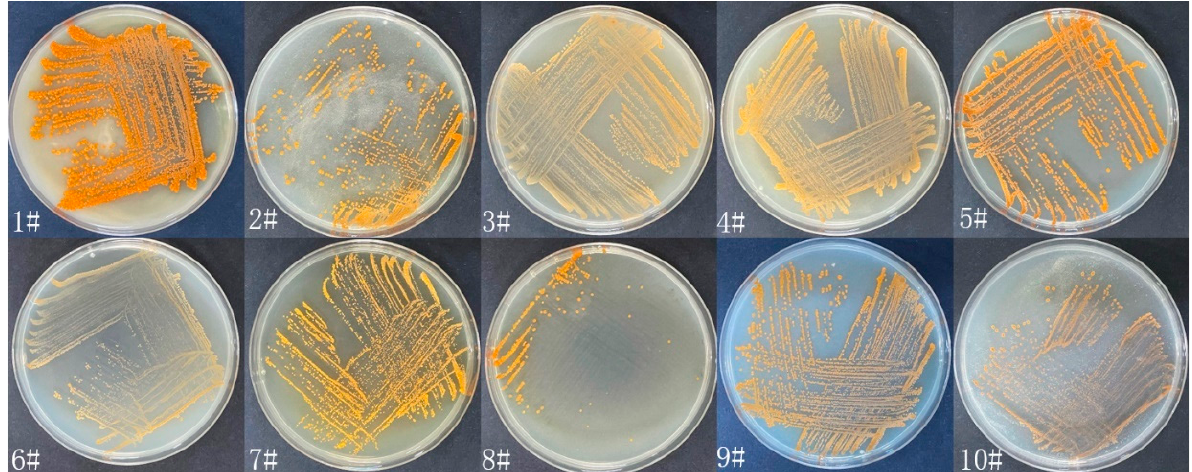
Figure 3. Nematicidal activities of ethyl acetate extracts of strain WH06 cultured in NB and LB media. CP represents blank control with 3% acetone. A represents the ethyl acetate extract of NB fermentation broth, and B represents the ethyl acetate extract of LB fermentation broth. Error bars represent the standard error of the mean ( n = 3). 3.2. Structural Identification of Compounds NB and 1# media were selected to culture Micromonospora sp. WH06. Ten compounds ( 1 – 10 ) were isolated from the ethyl acetate extracts of broth cultured on the two media. Their structures were identified using NMR and MS data (Figure 4). Compound 1 : yellowish oil; ESI–MS ( m / z ): 202 [M + Na] + ; 1 H-NMR (600 MHz, CDCl 3 ) δ : 7.03 (2H, d, J = 8.3 Hz, H-3/H-5), 6.82 (2H, d, J = 8.3 Hz, H-2/H-6), 3.49 (2H, m, H-8), 2.74 (2H, t, J = 7.0 Hz, H-7), 1.95 (3H, s, H-10); 13 C-NMR (125 MHz, CDCl 3 ) δ : 170.7 (s, C-9), 155.0 (s, C-1), 130.0 (s, C-4), 129.7 (d, C-3/C-5), 115.6 (d, C-2/C-6), 34.6 (t, C-7),